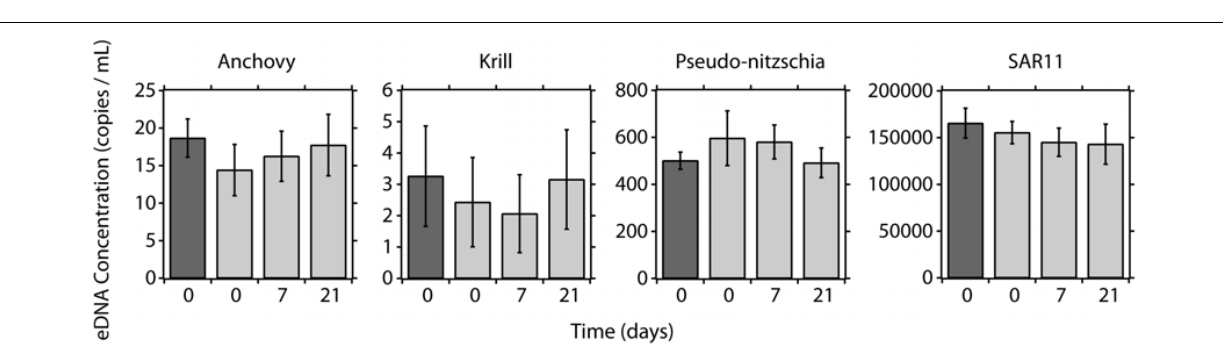
FIGURE 5 | eDNA preservation time series using the LRAUV-ESP. Concentrations of eDNA using peristaltic filtration (dark gray bars) and the ESP (light gray bars) at day 0, day 7, and day 21 of preservation on the ESP. Error bars represent 95% confidence